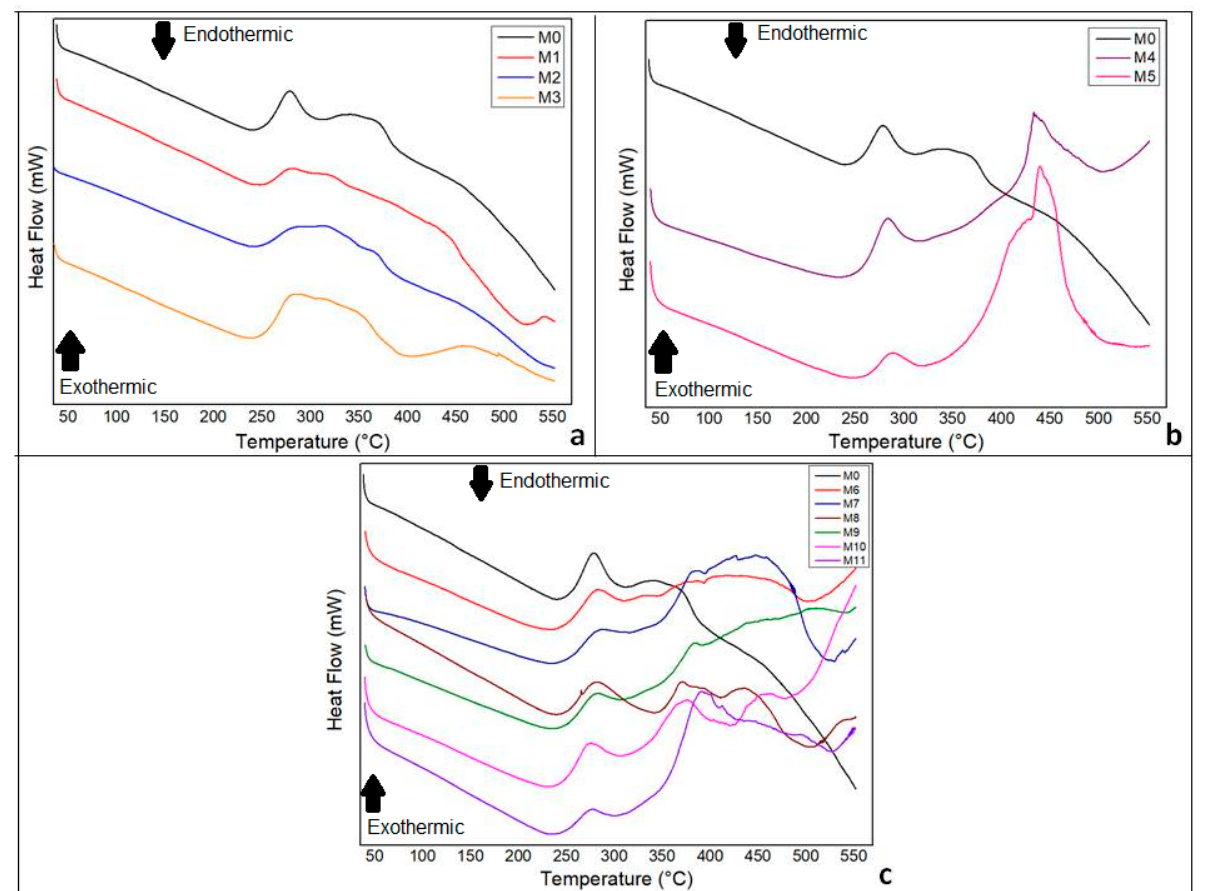
Figure 10. DSC analysis (second heat) of chitosan biomembranes. ( a ) Chitosan pure membrane (M0) and membranes with green banana peel extract (M1, M2 and M3) (M0). ( b ) M0 and chitosan membranes incorporated with andiroba oil (M4 and M5). ( c ) Chitosan membranes with green banana peel extract and/or andiroba oil.